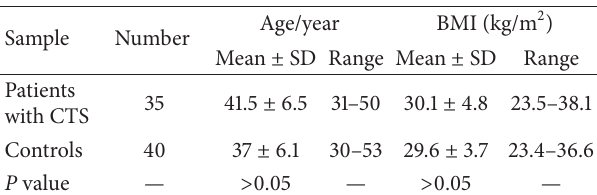
Table 1: The mean, standard deviation and range of age and BMI for the patient and control